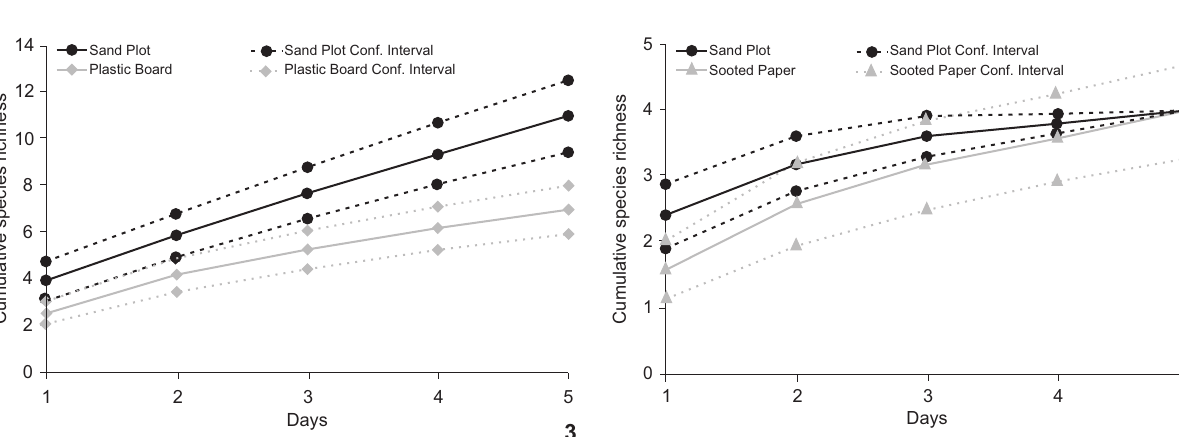
Sand Plot Sand Plot Conf. Interval Sooted Paper Sooted Paper Conf.